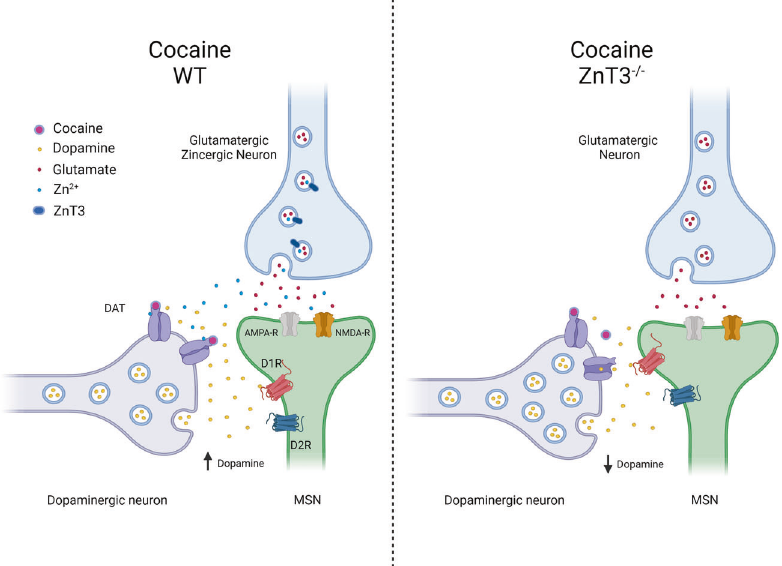
Fig. 6 Schematic representation of the putative mechanism by which presynaptic Zn 2 + modulates the effects of cocaine on dopamine and glutamate neurotransmission in the striatum in wild-type (WT) and ZnT3 knockout mice. The image on the left shows the effect of synaptic Zn 2 + on increasing cocaine ’ s ef fi cacy by binding to the DAT on dopaminergic neurons. It also acknowledges the putative effects of Zn 2 + on glutamate neurotransmission in the context of cocaine via its interaction with AMPA and NMDA receptors. The image on the right illustrates the effect of ZnT3 deletion, and consequently the loss of presynaptic Zn 2 + release, in attenuating the effects of cocaine on striatal dopamine and glutamate